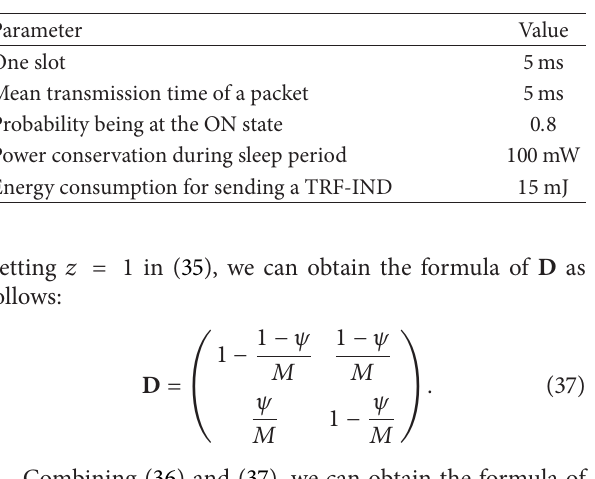
Table 1: System parameters.